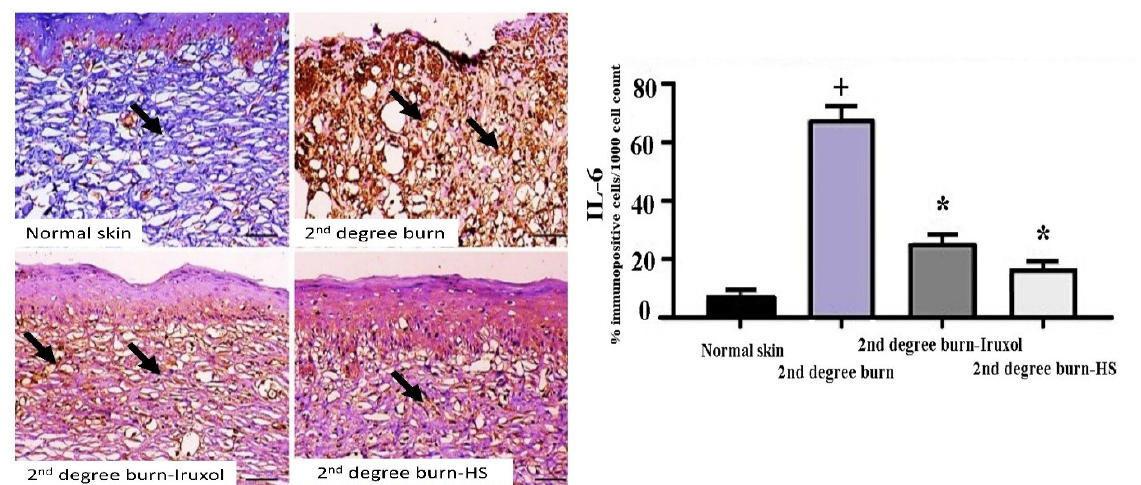
Figure 4. Immunohistochemical detection of IL-6 in skin tissues. Immunohistochemical detection of IL-6 in skin tissues, ×200. Arrows indicate expression of IL-6 within the dermal layers of different groups. Marked immunolabeling was detected in the 2nd degree burn group of rats, while decreased expression was detected in the treatment groups. Bar = 100 µ m. +, p < 0.05 vs. normal group; *, p < 0.05 vs. 2nd degree burn